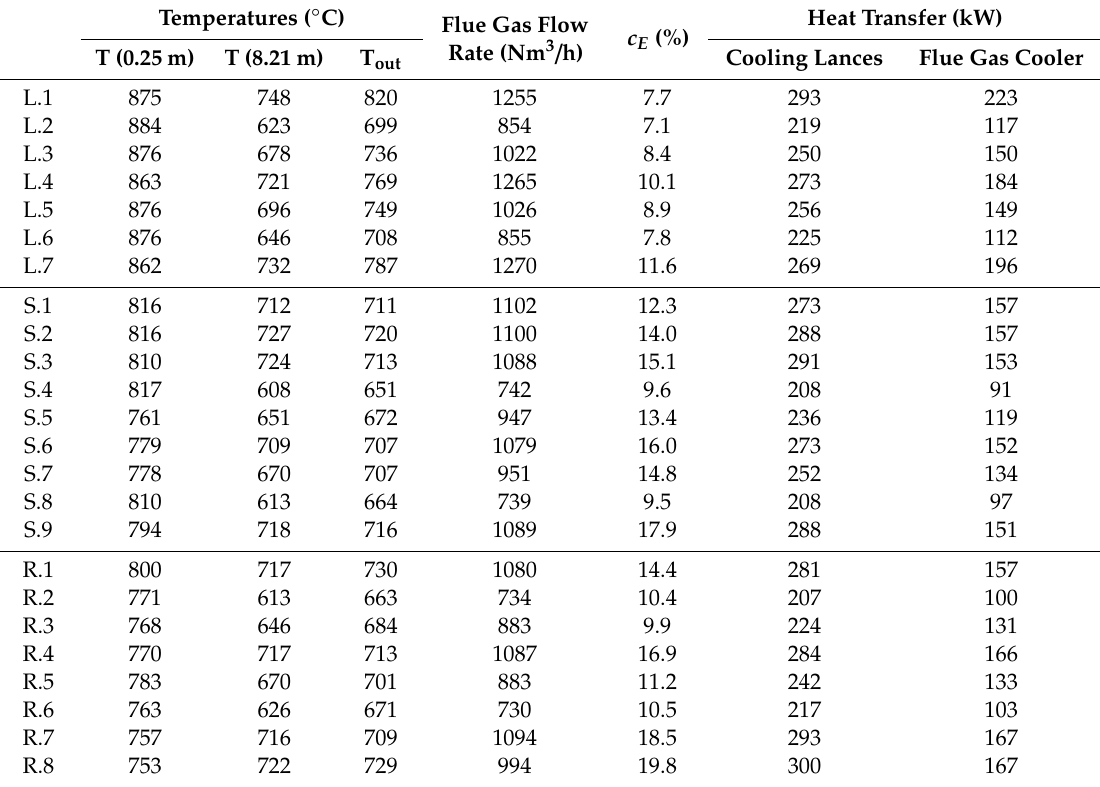
Table A2. Temperatures, flue gas flow rate, entrainment, and heat transfer during